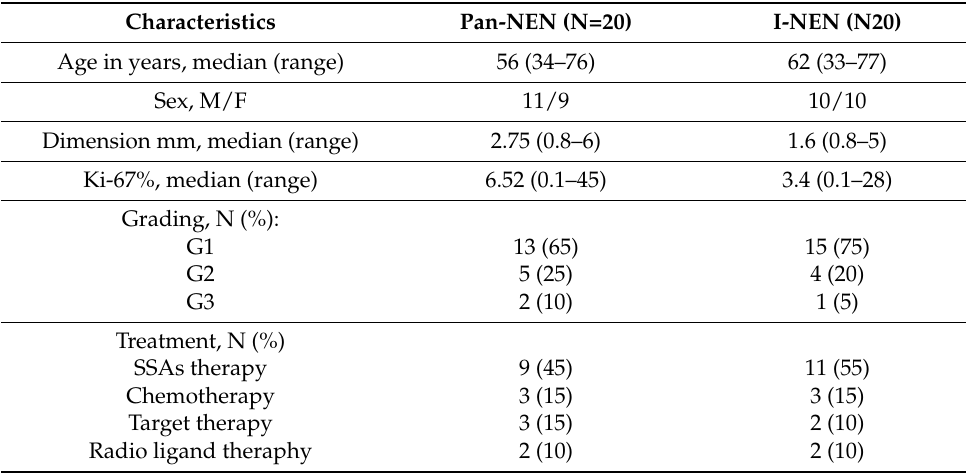
Table 1. Demographic and clinical characteristics of the NEN patients.